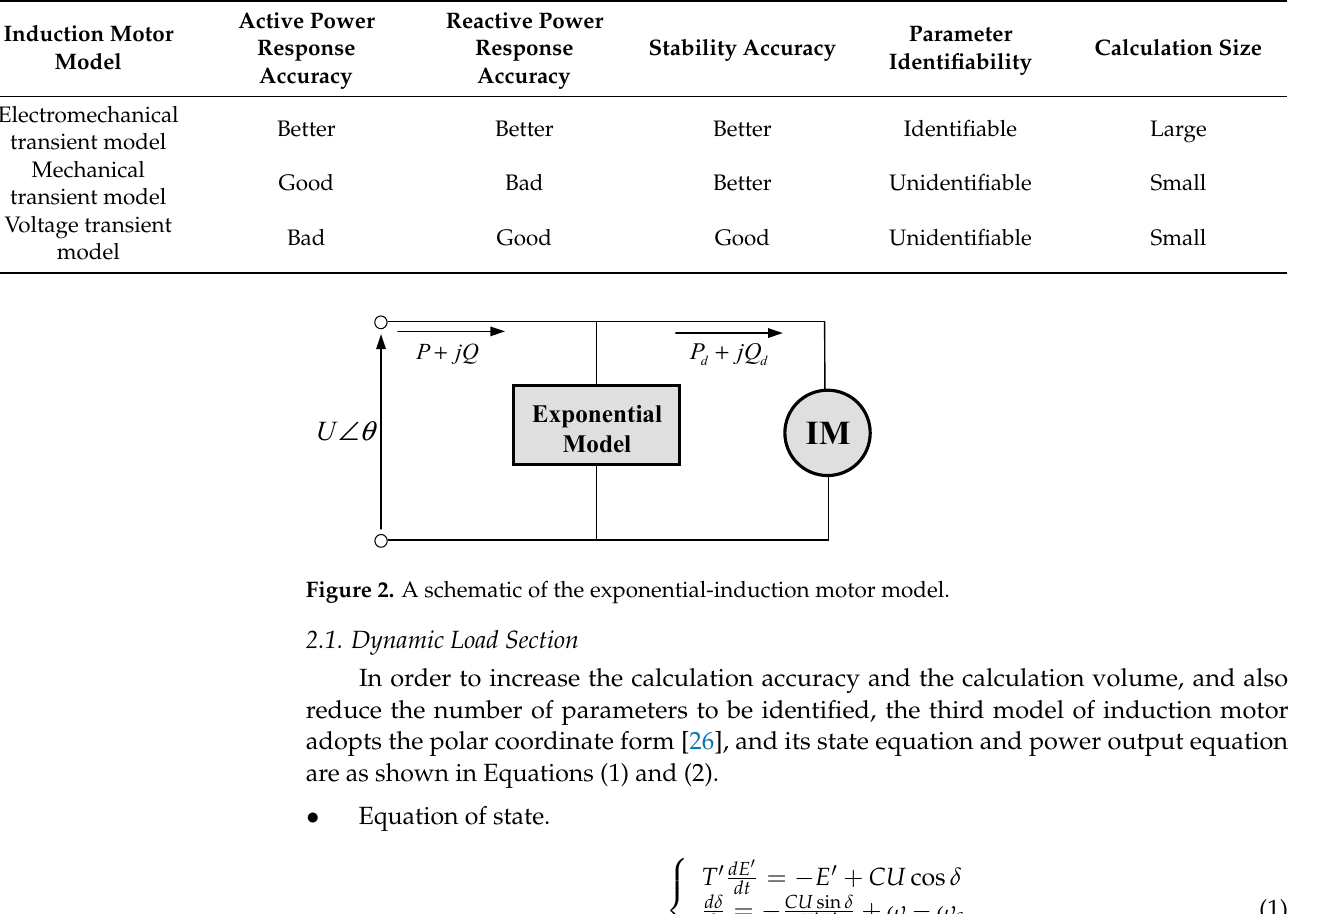
Table 1. Comparison of three induction motor models.